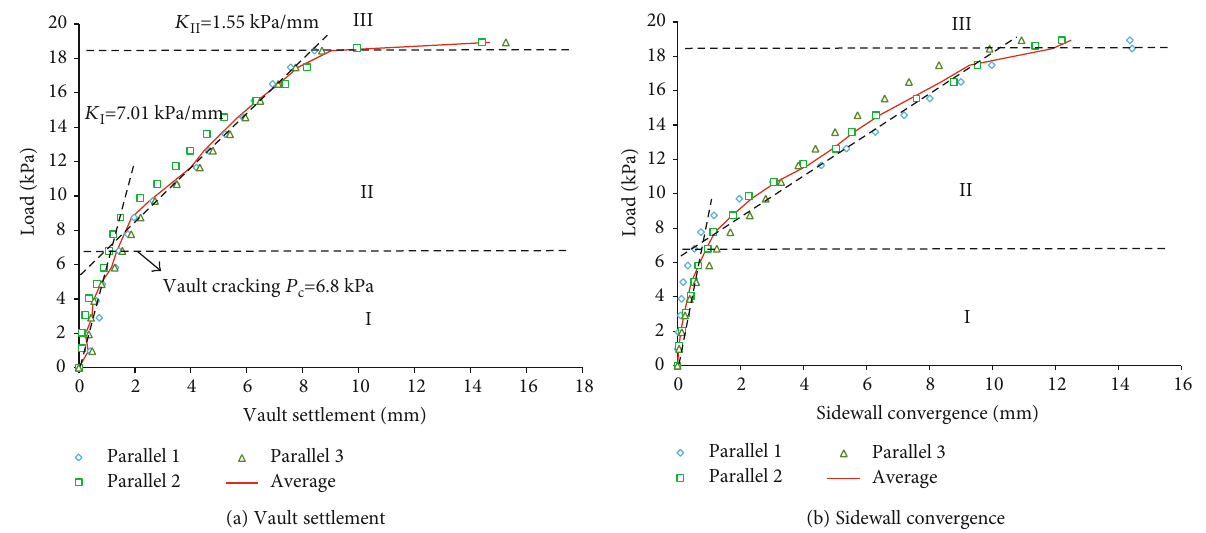
Figure 4: Results of parallel tests.